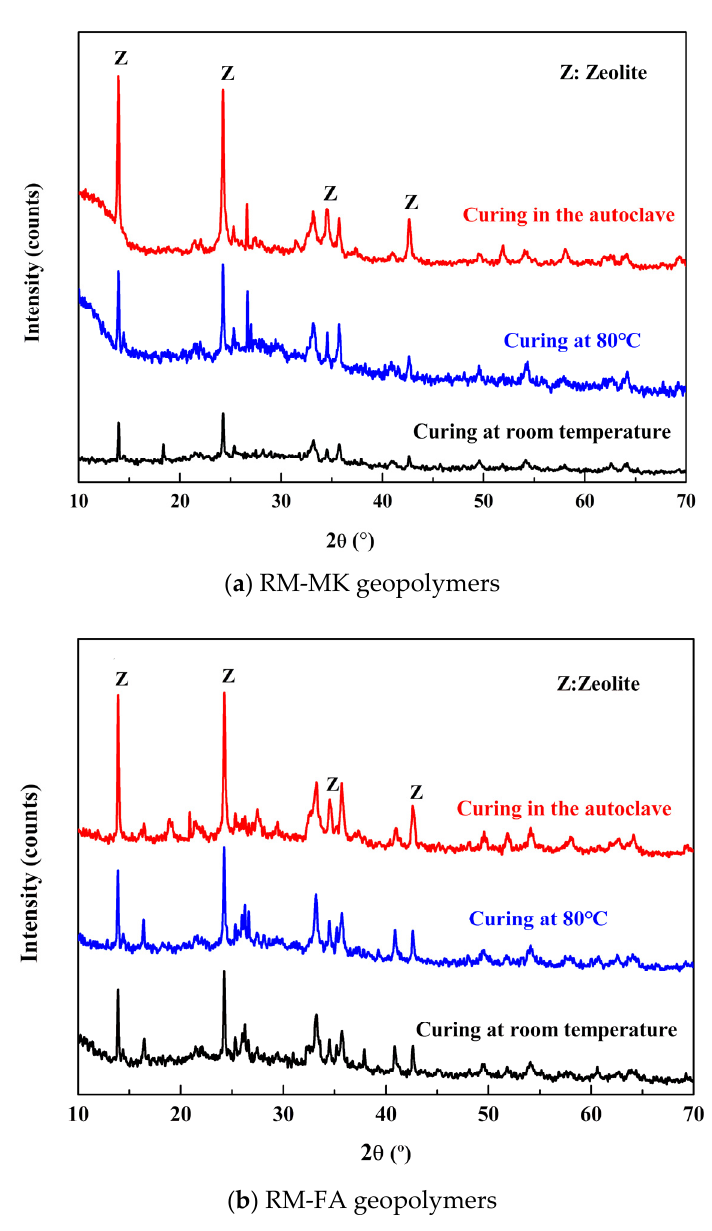
Figure 4. XRD pattern of the geopolymers with a 50% red mud content.